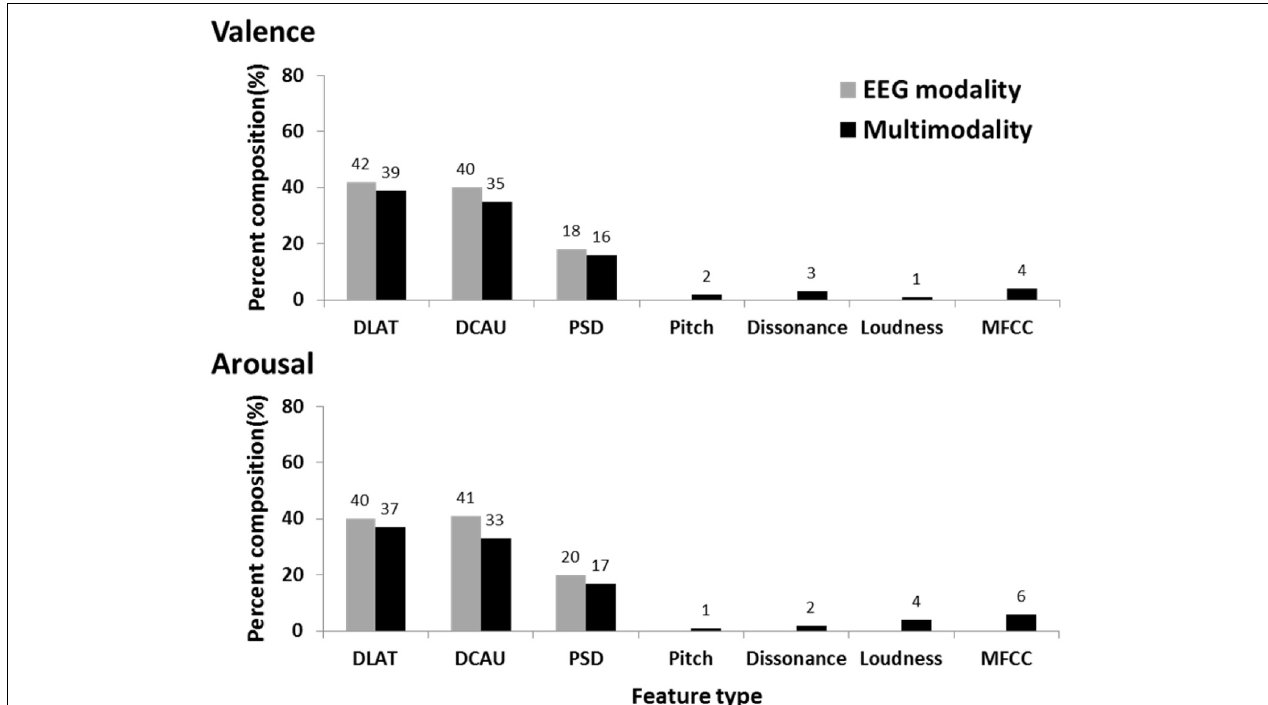
FIGURE 4 | The percent composition of contributions of EEG (DLAT, DCAU, and PSD) and musical (Pitch, Dissonance, Loudness, and MFCC) features to the subject-dependent multimodality. The composition of the subject-dependent EEG modality is also provided for